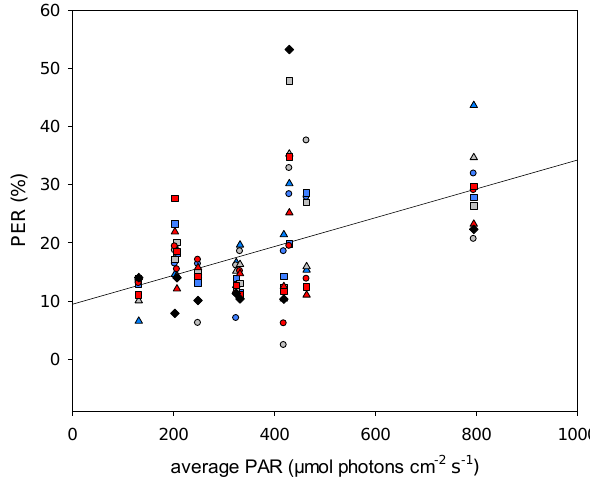
Fig. 7. PER during the total period of observation (day 5–day 28) increased with average PAR received during the 24h bottle incuba- tions. For color information see Fig.